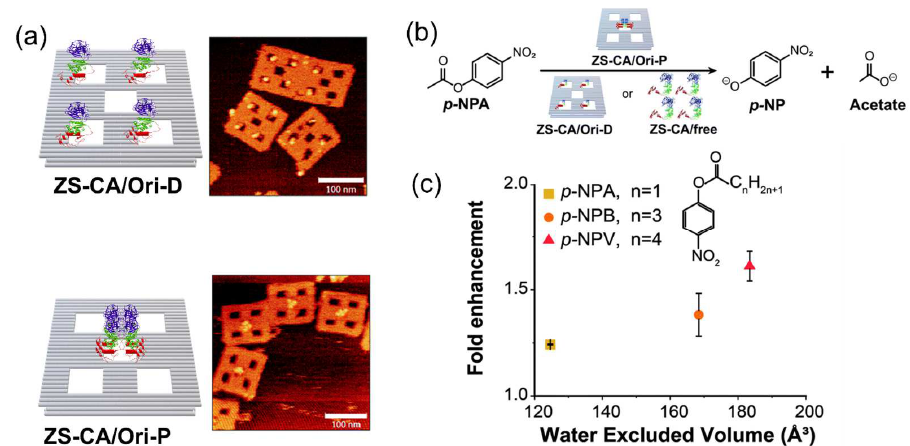
Figure 8. Carbonic anhydrase (CA) was assembled on the DNA scaffold in a dispersed or packed state [85]. ( a ) ZS-CA (modular adaptor ZF-SNAP fused CA) assembled on the DNA scaffold in a dispersed state (ZS-CA/Ori-D) or packed state (ZS-CA/Ori-P). The scale bar of the AFM images was 100 nm. ( b ) The reaction scheme presenting the hydrolysis of p -nitrophenyl acetate ( p -NPA) catalyzed by CA. ( c ) The enhancement factors (initial velocity of CA on Ori-P over that of CA on Ori-D) for the esterase reaction of ZS-CA plotted against the water-excluded volume of p -NPA, p -nitrophenyl butyrate ( p -NPB) and p -nitrophenyl valerate ( p -NPV). Printed with permission from Ref. [85], Copyright 2021 Royal Society of Chemistry.